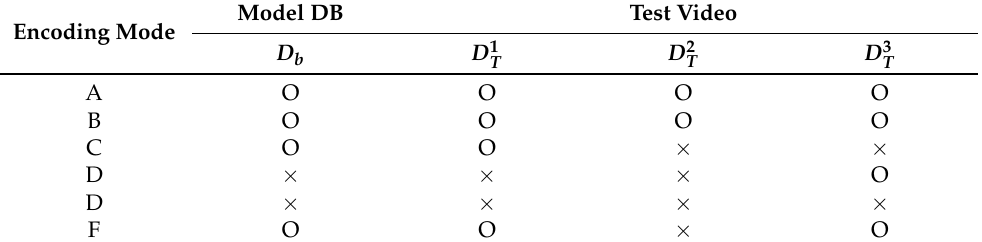
Table 8. Three types of comparison results. Here, O and × represent ‘used’ and ‘not used’, respectively.